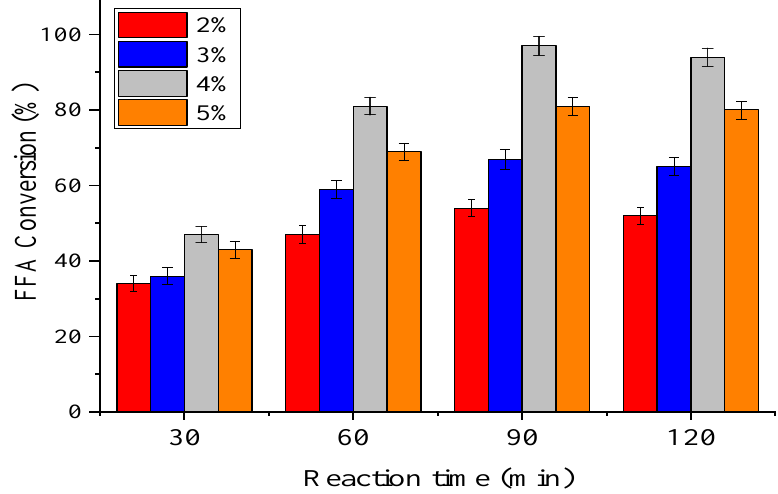
Figure 6. E ff ect of catalyst loading on FFA